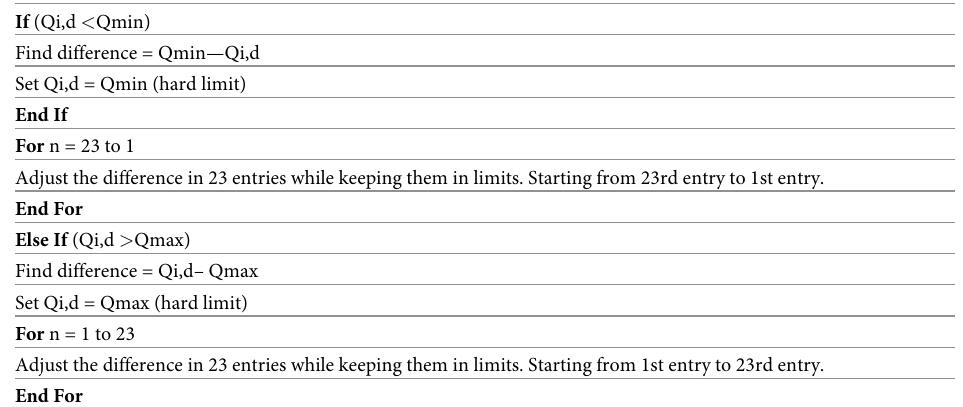
Table 1. Pseudocode for newly proposed constraint handling